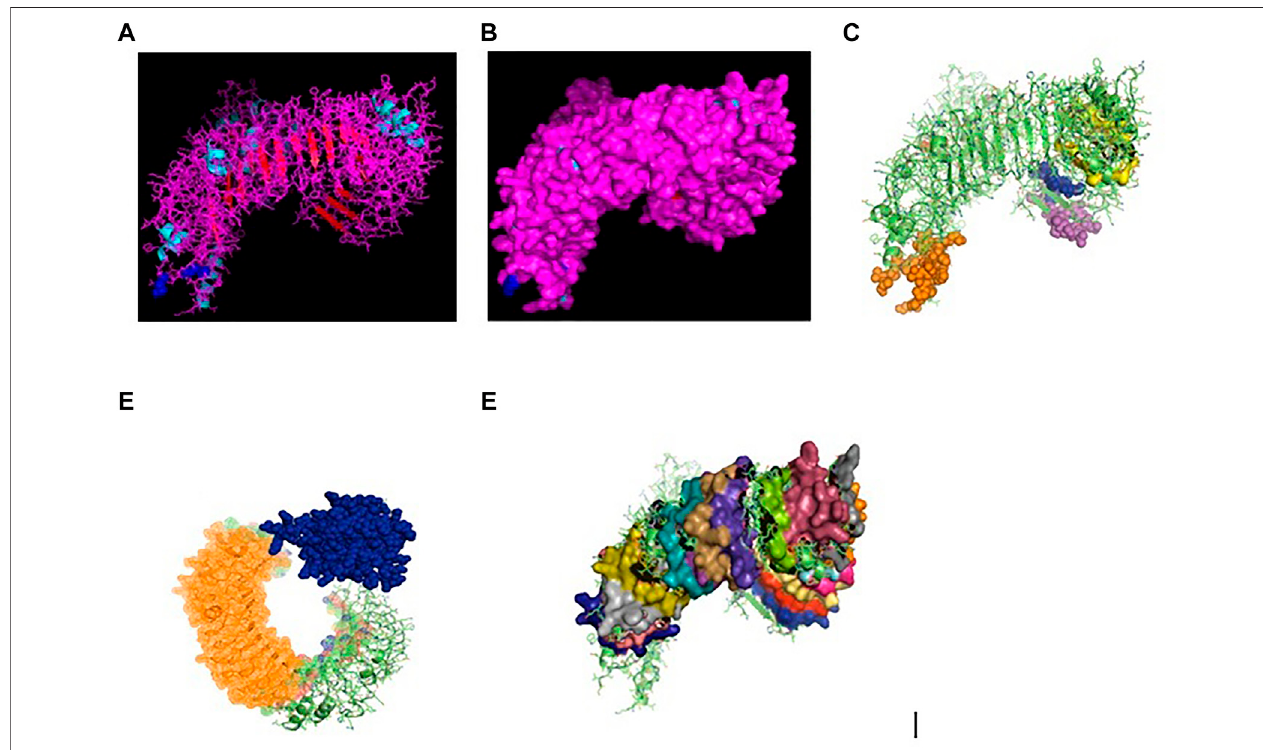
FIGURE1|(A) TLR3moleculeofduck(secondarystructurewithdisulphidebond)asbluesphere. (B) TLR3moleculeofduck(secondarystructurewithdisulphide bond) surface view. (C) 3D structure of TLR3 of duck: yellow surface: leucine zipper (151 – 172), red sphere: GPI anchor (879), blue sphere: leucine-rich nuclear export signal, magenta sphere: LRRNT (37 – 51), orange sphere: LRRCT (664 – 687). (D) 3D structure of TLR3 of indigenous duck, blue sphere: TIR (748 – 890), orange mesh: leucine-rich receptor-like proteinkinase. (E) 3D structure of TLR3 of duck with leucine-rich